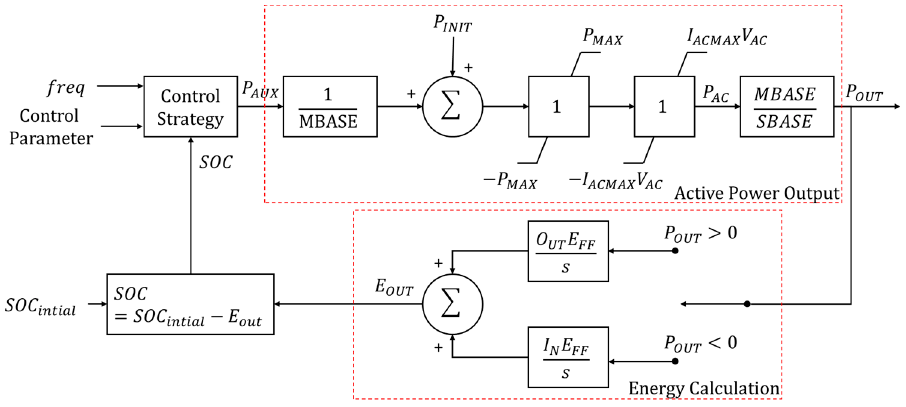
Figure 8. Modeling the BESS using the CBEST model in PSS/E.